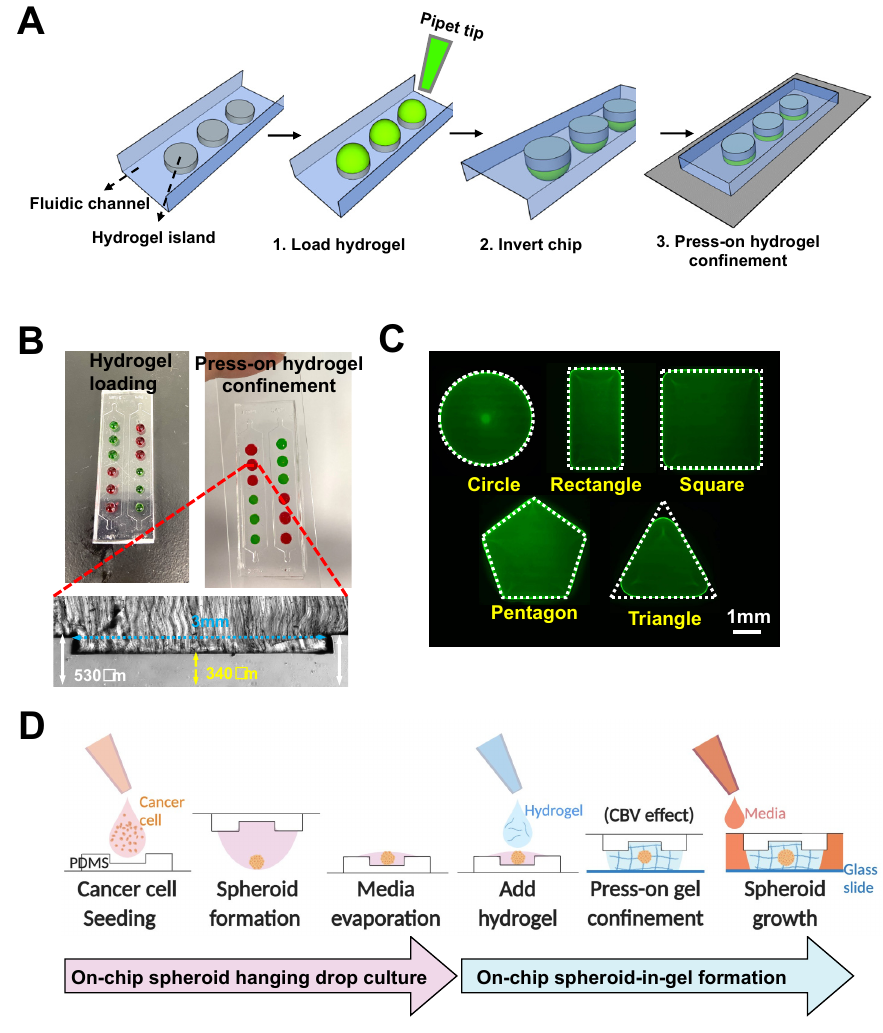
Figure 2. Rapid “press-on” hydrogel patterning in an open-channel microarray chip. ( A ) Schematic illustration of press-on hydrogel confinement on patterned islands on PDMS substrate. ( B ) Demon- stration of gel loading and press-on gel confinement using Collagen I (3 mg/mL) mixed with red or green food dye (top). Cross-sectional image of the device, yellow arrows indicate the stepped height of ~190 μ m (bottom). ( C ) Fluorescence images of FITC-laden Collagen I confined within different shapes of hydrogel island. White dotted line indicates the shape of the patterned hydrogel island. ( D ) Schematic illustration of workflow for on-chip spheroid-in-gel formation. Schematics were created with